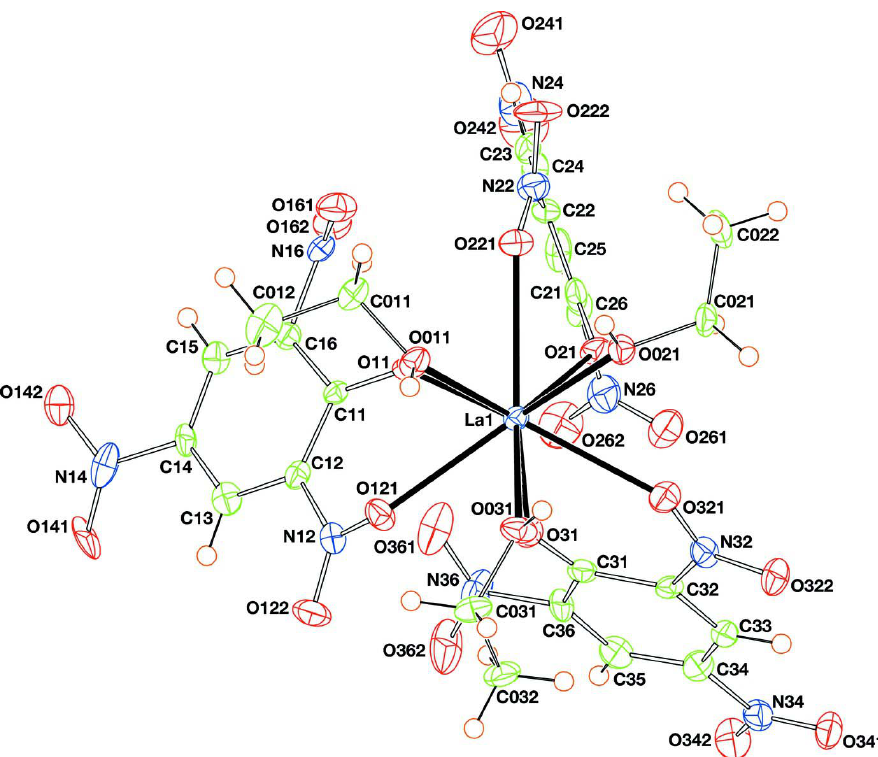
Figure 2 Labelled ORTEP diagram of the tris(ethanol- O )tris(picrato- O , O′ )lanthanum(III) neutral mononuclear adduct projected through the triangular faces of its 9-coordinate tri-capped trigonal prismatic metal environment. 50% probability displacement ellipsoids are shown for non-H